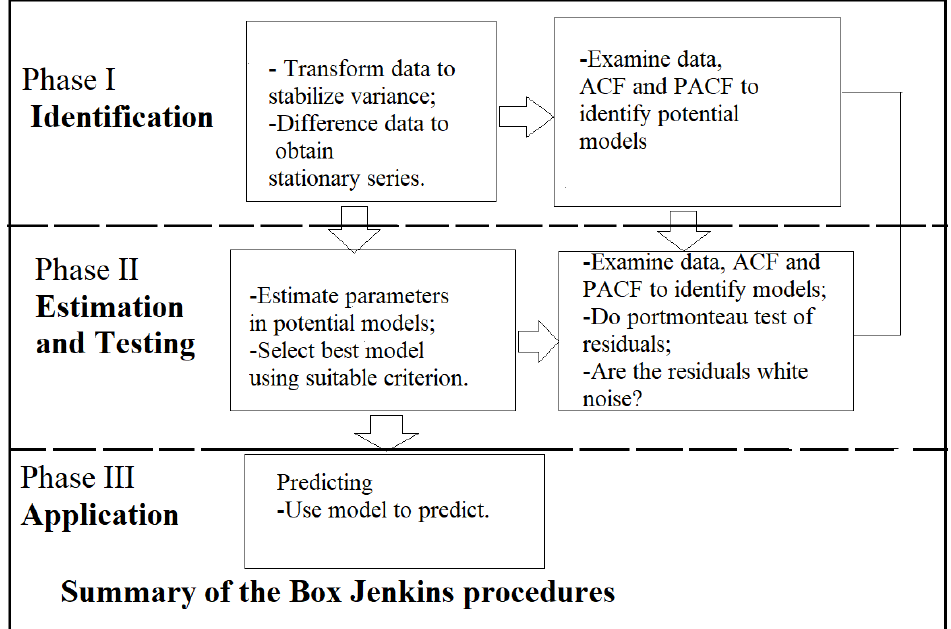
Figure 5. The Box–Jenkins method.